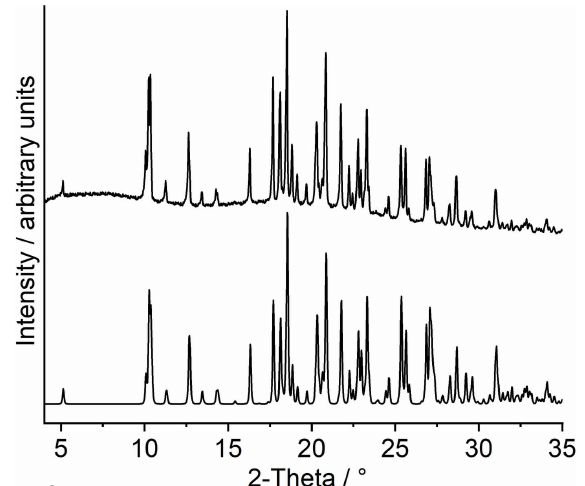
Figure 3 Experimental (top) and calculated PXRD pattern (bottom) of the title compound.